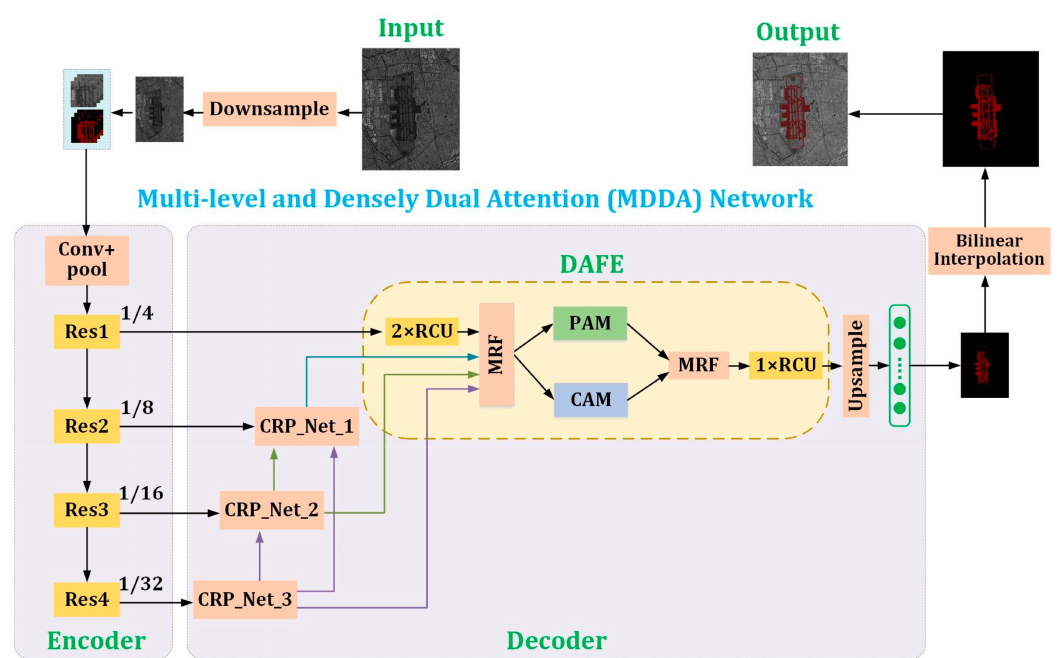
Figure 5. The multi-level densely double attention network for airport